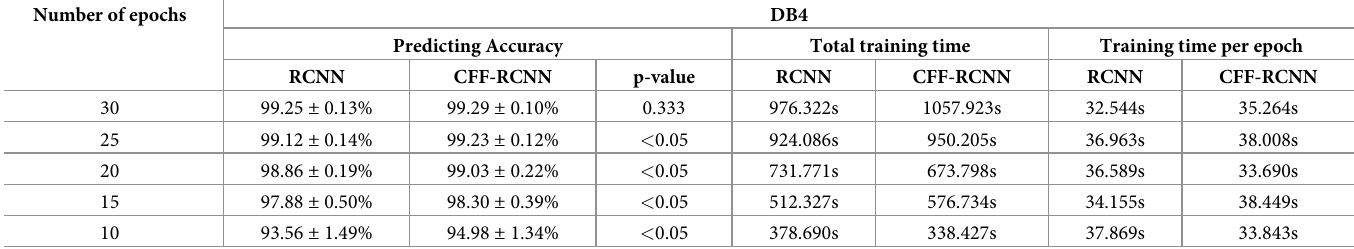
Table 6. Predicting accuracy, total training time, and training time per epoch of the RCNN and CFF-RCNN on DB4 at different epochs, along with the statistical analyses results. Number of